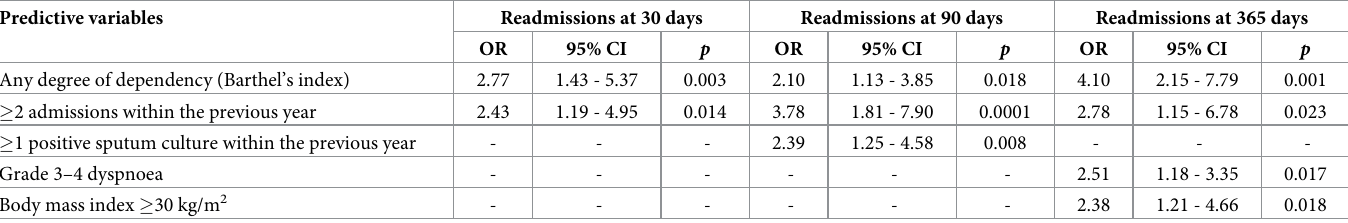
Table 3. Variables predicting readmission at 30, 90, and 365 days in the multivariate analysis. Predictive